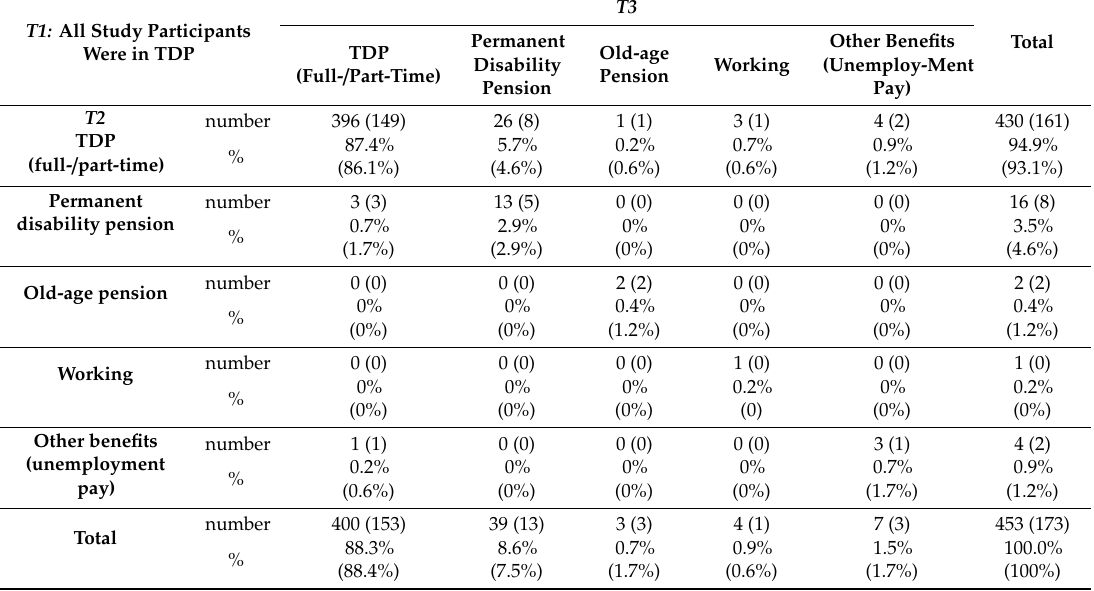
Table 1. Work status of study participants at T2 and T3: Whether they maintained in temporary disability pension (TDP), moved to permanent disability pension, old-age pension, employment, or other benefits with imputed numbers (last-observation-carried-forward method) as well as participants who actually provided data (in